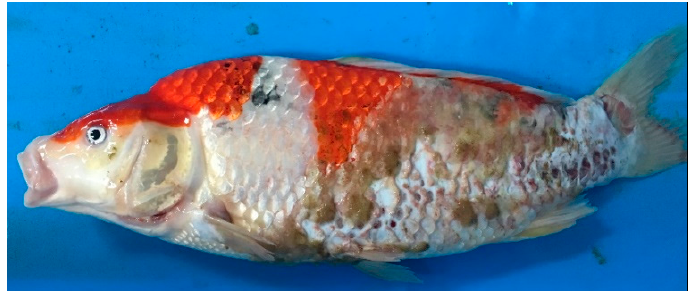
Figure 1. Gross examination of carp edema virus-infected Cyprinus carpio koi showing slightly sunken eyes and erosive and ulcerative skin with cotton wool-like.